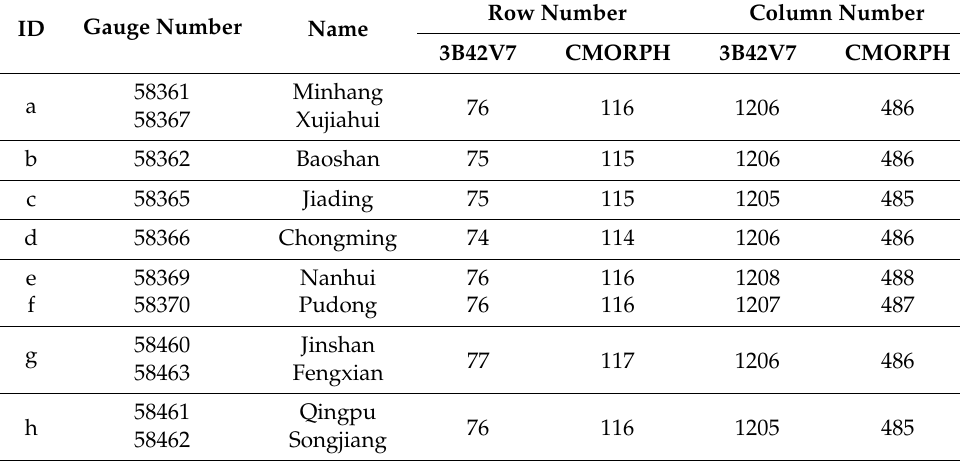
Table 1. Detailed information of rain gauges and satellite-based rainfall